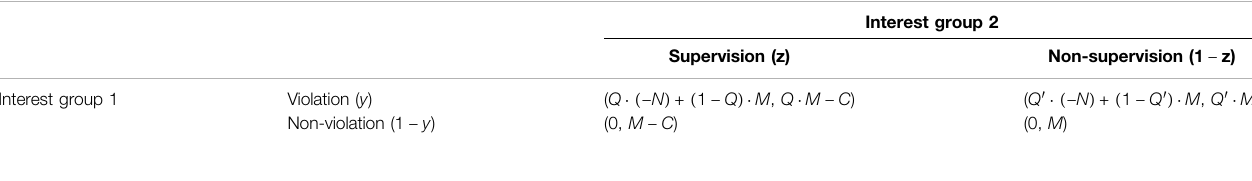
TABLE 2 | Payment matrix between interest group 1 and interest group 2.